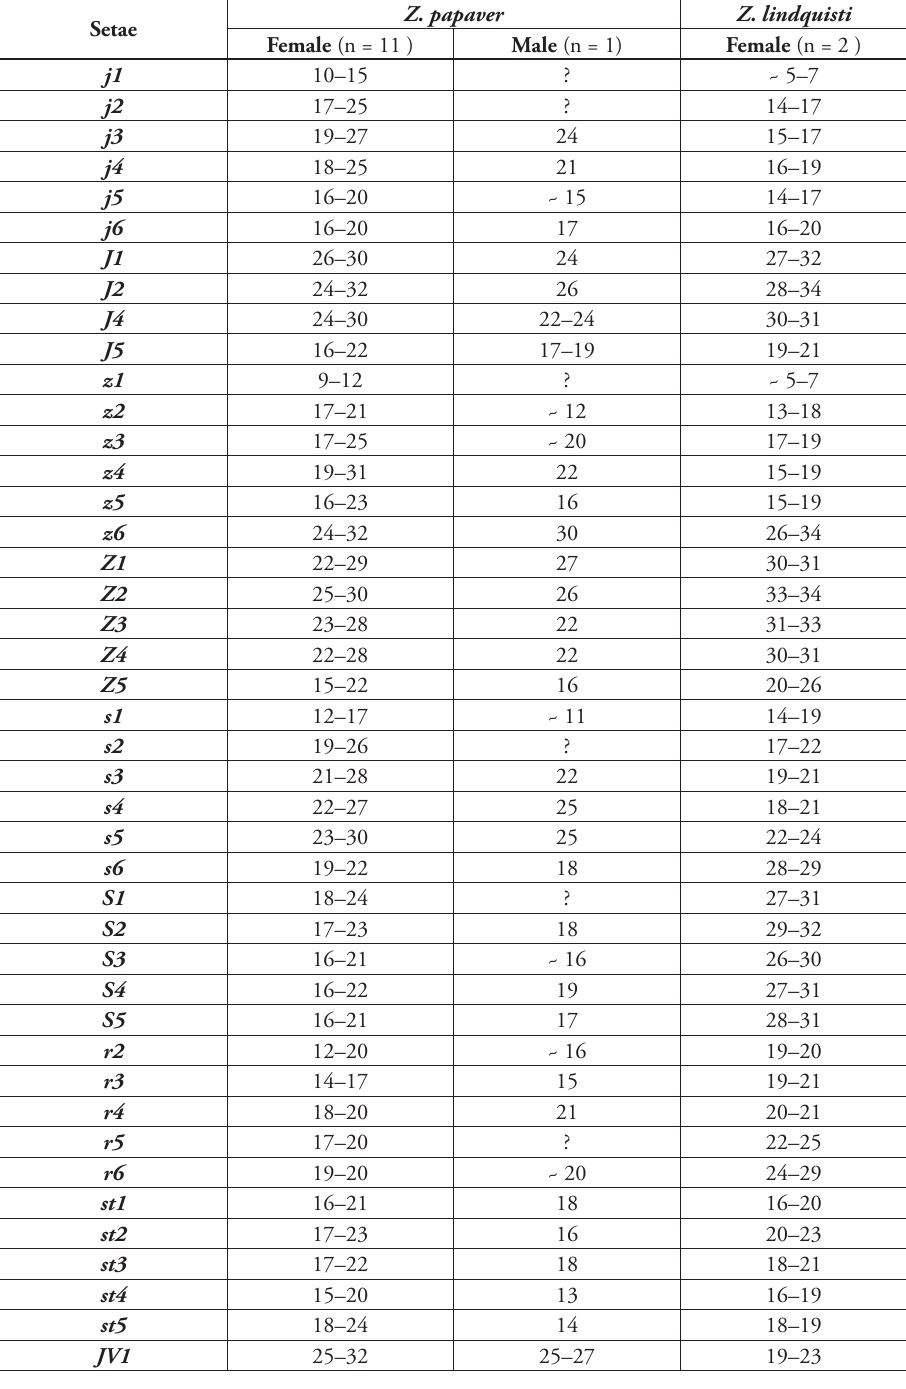
Table 1. Lengths of most idiosomal setae of Zygoseius papaver sp. n. and Z. lindquisti sp. n.